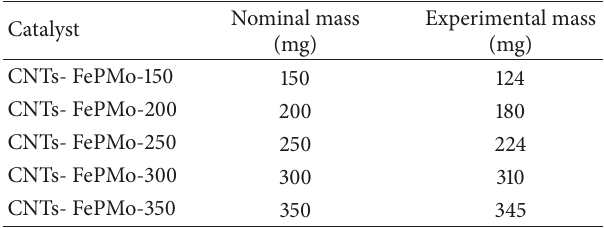
Table 3: Determination of the amount of Fe 1.5 PMo 12 loaded on the CNTs support by UV-visible